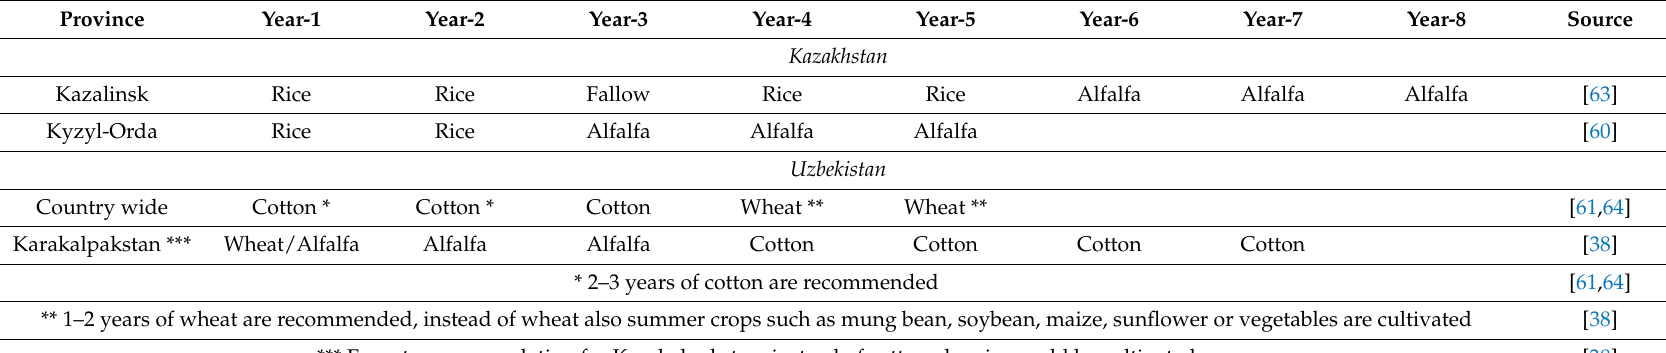
Table 2. Typical crop rotations for selected areas in the Aral Sea Basin. (Shown is one complete cycle of either the recommended or the mandatory cropping